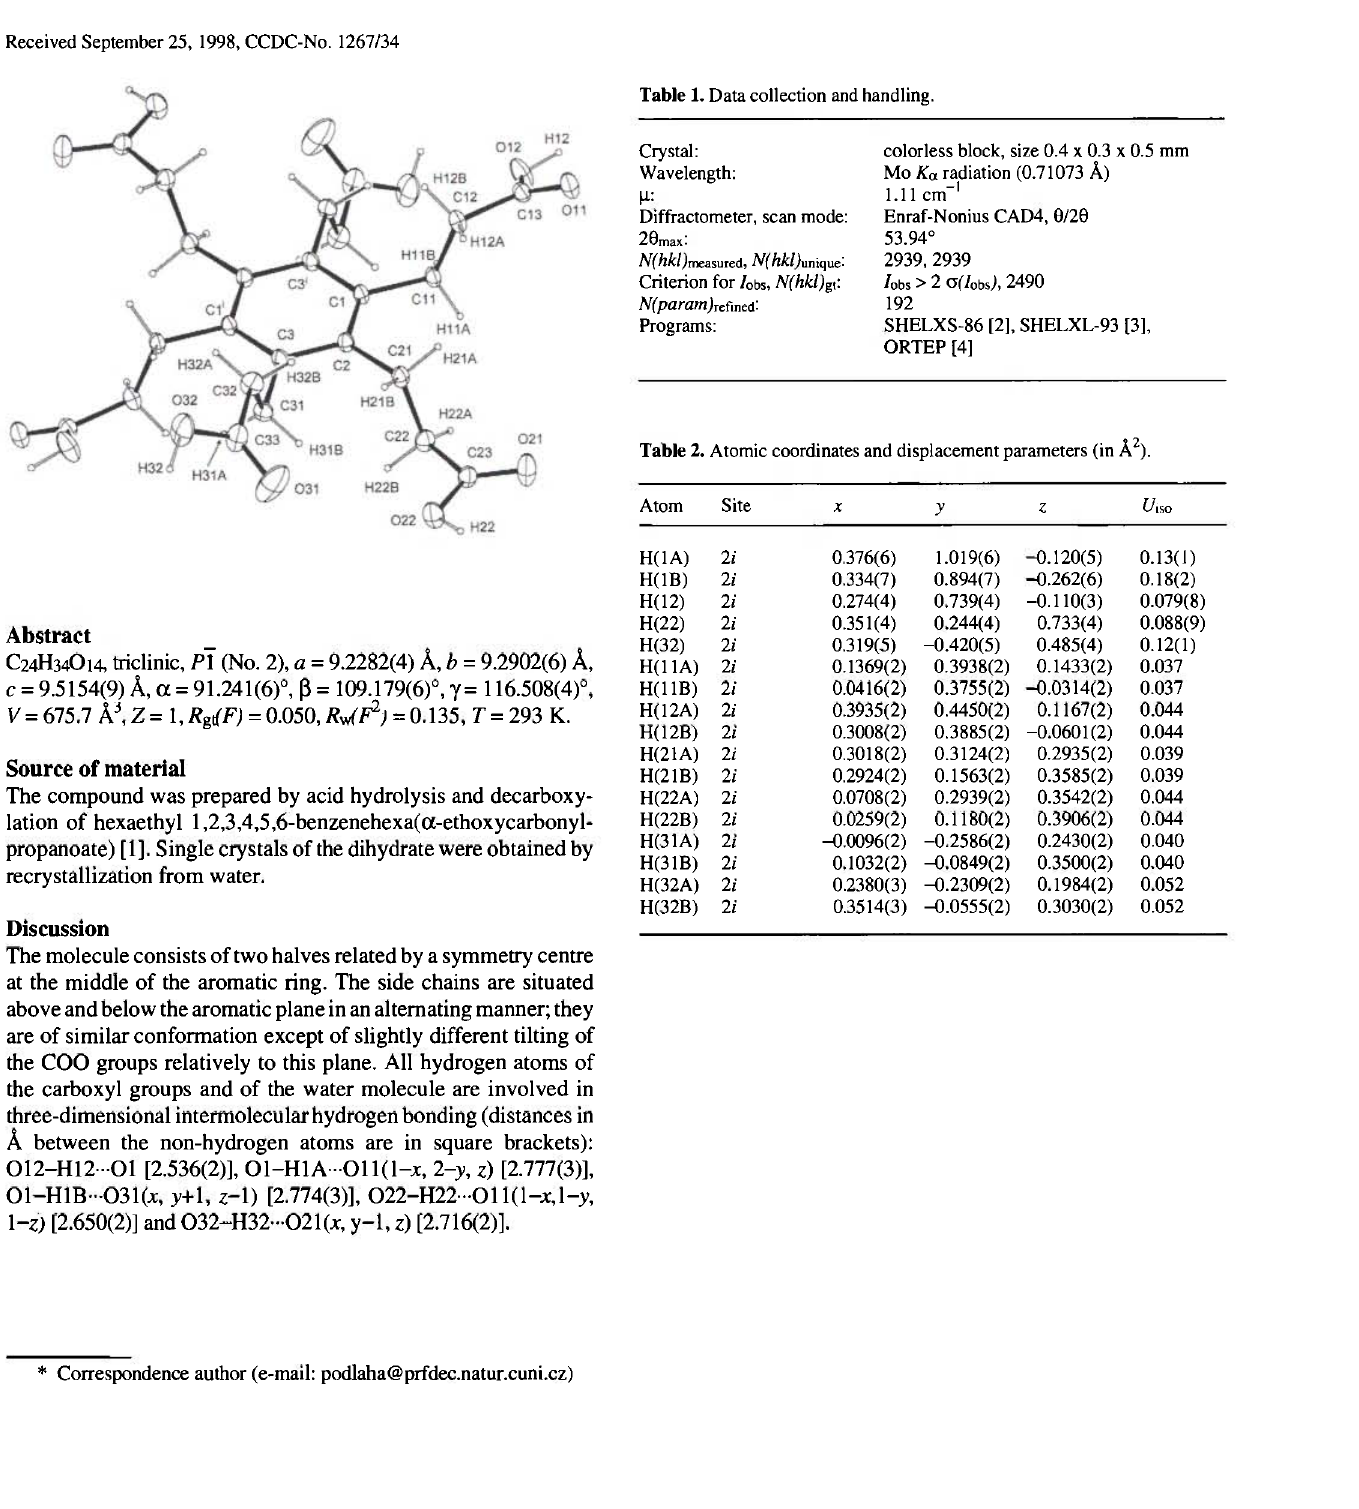
Table 2. Atomic coordinates and displacement parameters (in Ä 2